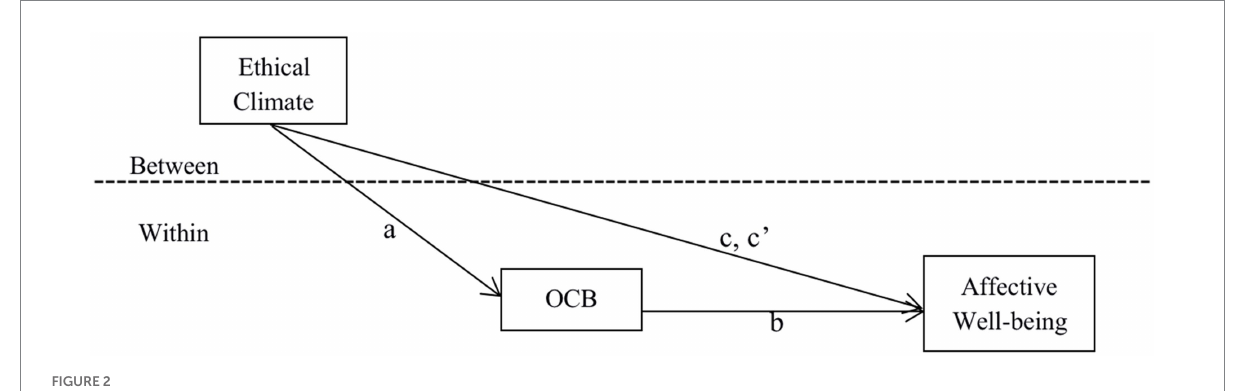
FIGURE 2 Multi-level mediation in a 2-1-1